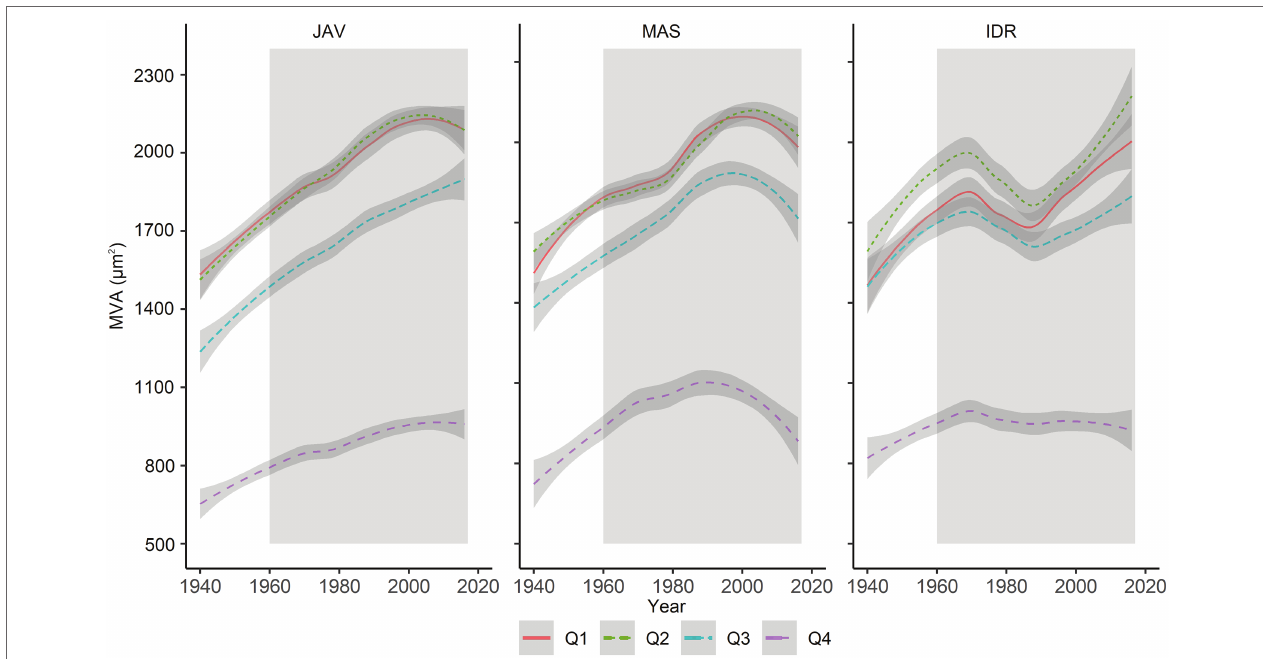
FIGURE 4 | Long-term trends in MVA in evaluated tree-ring quarters (Q1–Q4) at Javornik (JAV), Mašun (MAS) and Idrija (IDR). The gray area represents the period between 1960 and 2016, which was considered for further analysis. The relationships between sectors are presented in Supplementary Figure S1